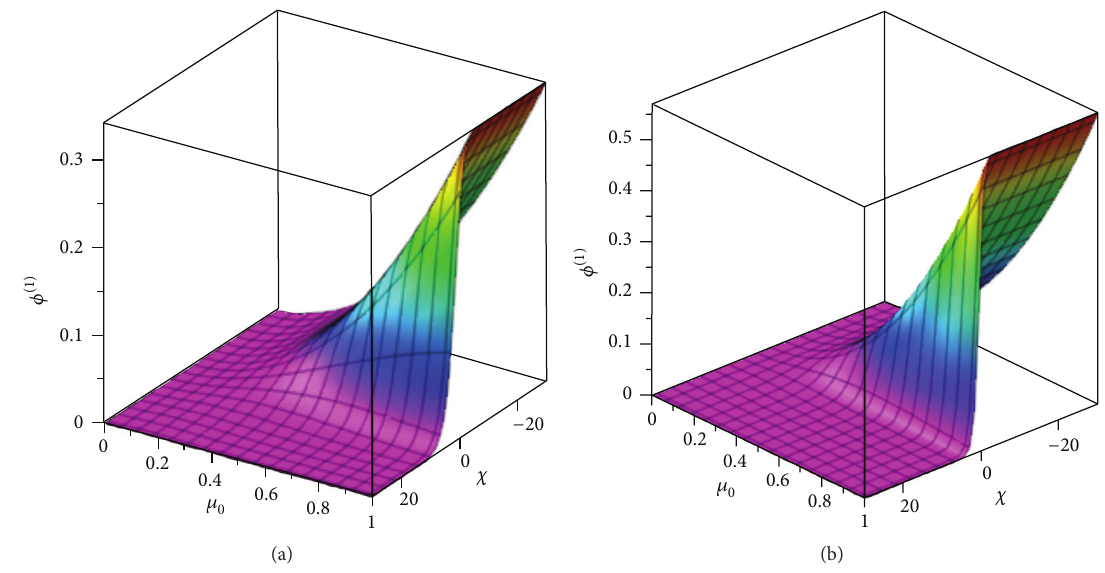
Figure 2: Influence of 𝜇 0 on the spatial potential ( 𝜙 (1) ) profiles of IA shock waves of the plasma system considered, taking 𝛼 = 0.4 , 𝜎 = 1 , 𝛿 = 0.01 , and 𝛽 = 0.1 for the thermality parameter (a) 𝑞 = 0.6 and (b) 𝑞 = 2 .